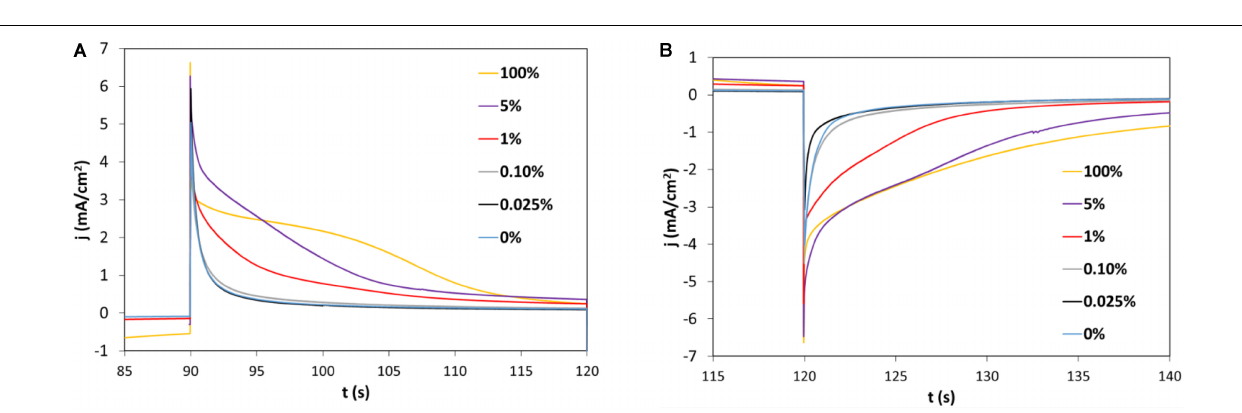
Frontiers in Materials |